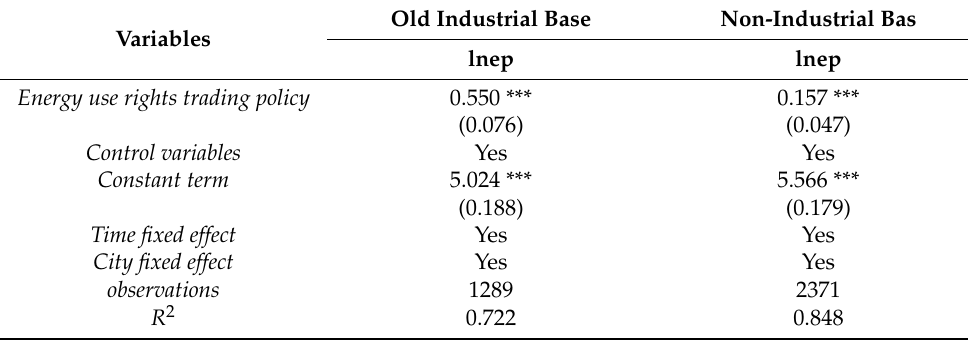
Table 5. Heterogeneity test between industrial bases and non-industrial bases.